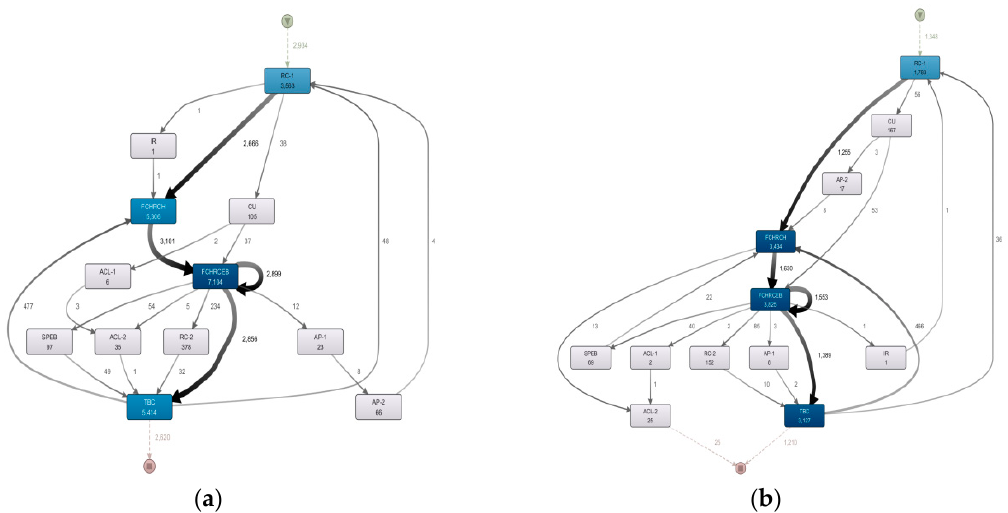
Figure 13. Process models of service problem ( a ) and sale problem ( b ) CHS cases.